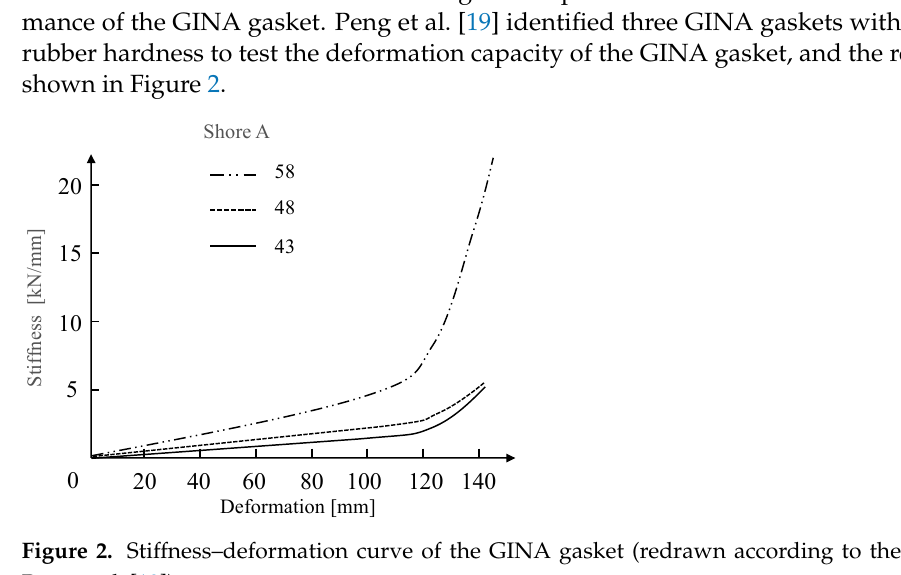
Figure 2. Stiffness–deformation curve of the GINA gasket (redrawn according to the results of Peng et al. [19]).